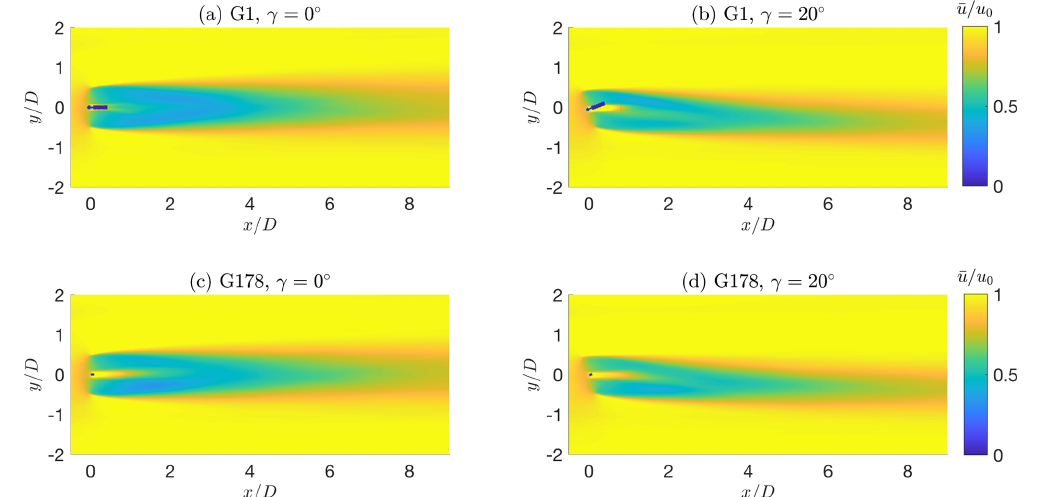
Figure 9. Wakes of the scaled G1 (a, b) and full-scale G178 (c, d) turbines. (a, c) Aligned case; (b, d) yaw misaligned case.